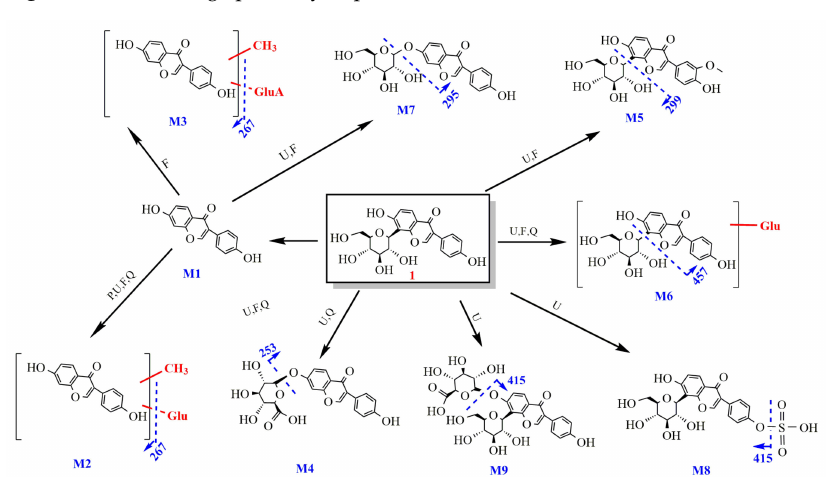
Figure 5. The cleavage pathway of puerarin.